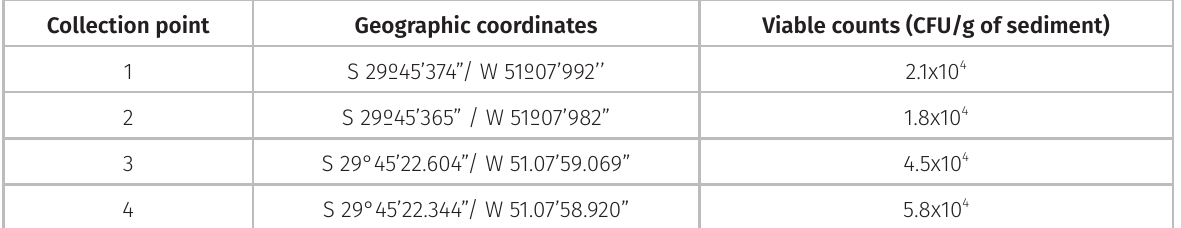
Table II. Quantification of heterotrophic bacteria in the analyzed sediment, per sample collection point. Collection point Geographic